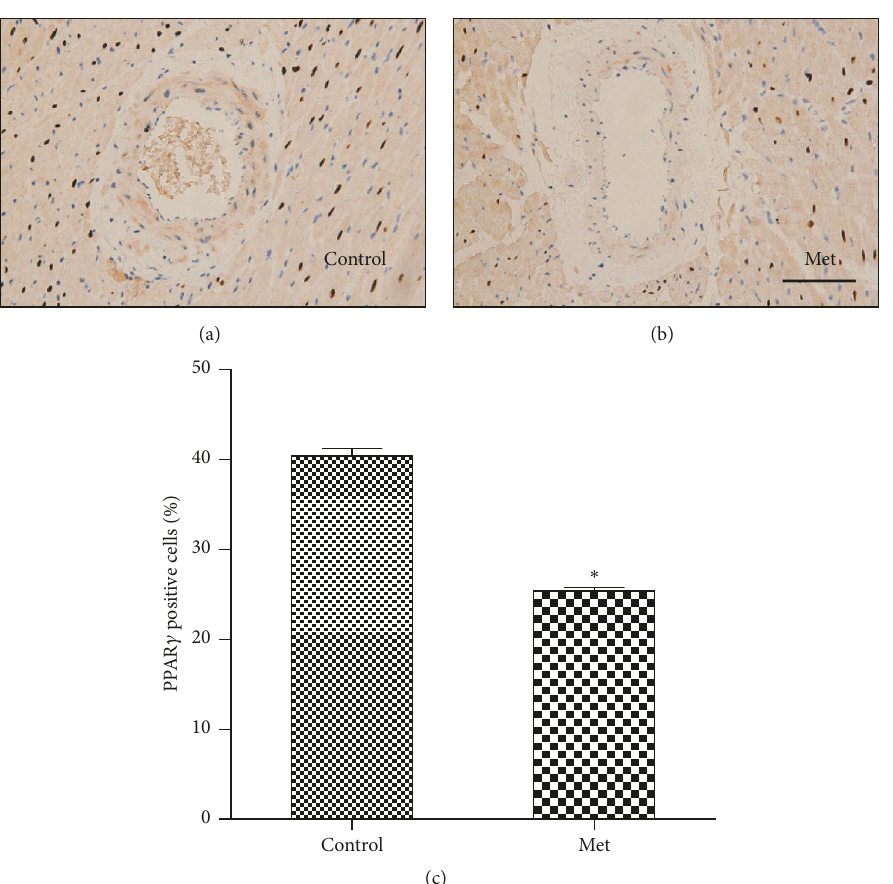
Figure 5: Representative immunohistochemical images of PPAR 𝛾 in the coronary arteriole in the control-diet group (a) and the Met-diet group (b). Positive staining of PPAR 𝛾 was found in the nuclei of the cells. The Met-diet group had significantly fewer PPAR 𝛾 positive cells ( ∗ 𝑝 < 0.05 ) (c). Original magnification was × 200 for (a)-(b) and the scale bar = 100um. Values are mean ±